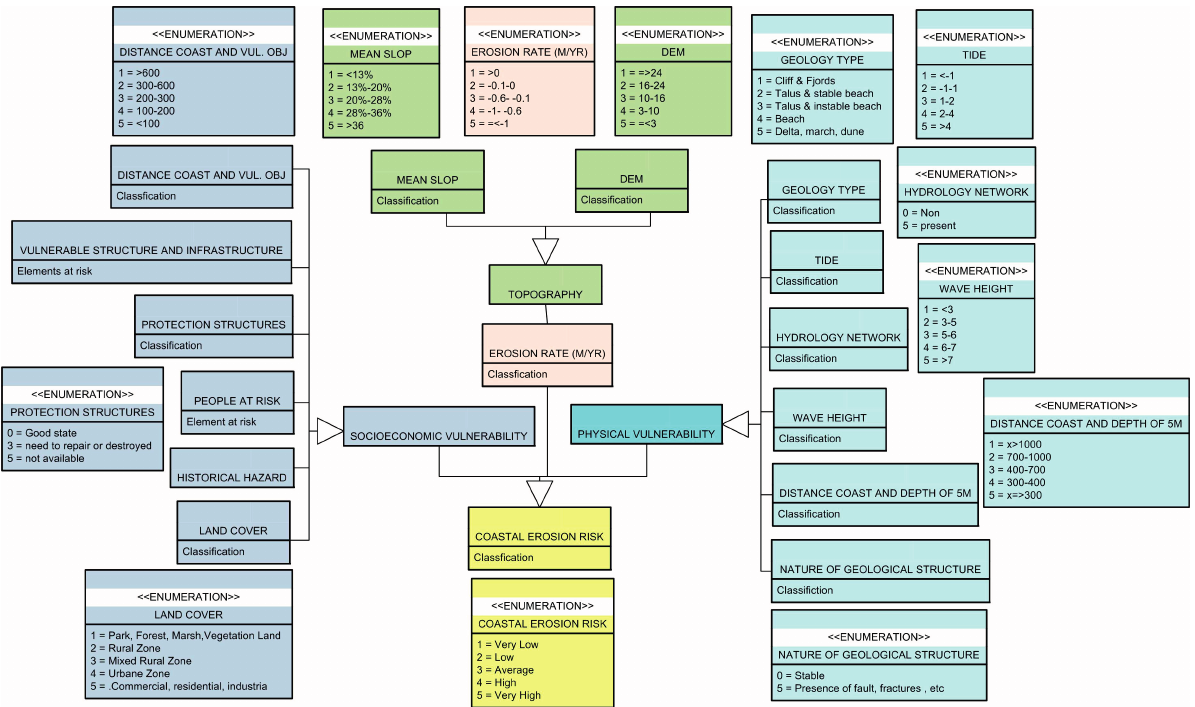
Figure 4. UML class diagram of a generic schema of coastal erosion risk assessment adapted from